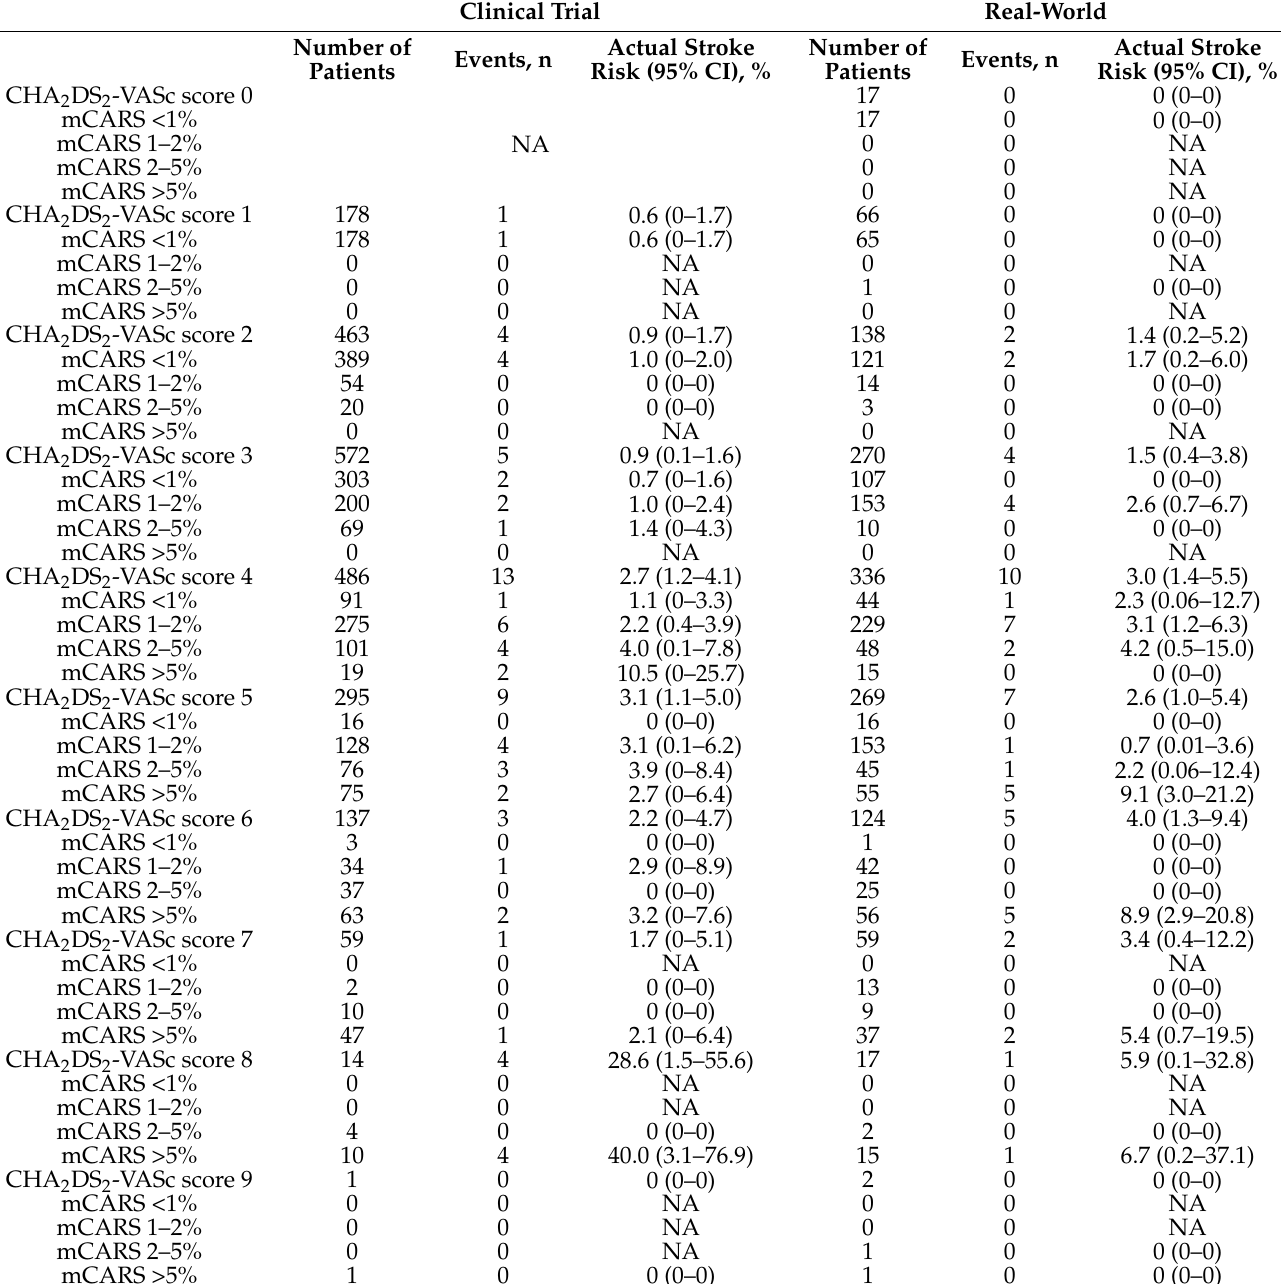
Table 4. Breakdown of actual stroke risk based on mCARS for subgroups of the CHA 2 DS 2 -VASc score. Clinical Trial